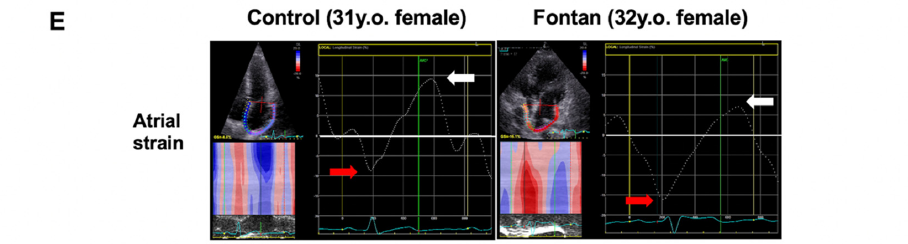
Figure 5. Atrial function in atrial septal defect and Fontan palliation. ( A ) TEE showing a right-to-left (R-L) shunt from a residual leak after ASD device closure with RA dysfunction. ( B ) Four-chamber views of end-systole (RAA max) and end-diastole (RAA min). The decreased RA fractional area change (FAC) suggests RA dysfunction. ( C ) Illustration of the Fontan circulation and the process of impairment of systemic ventricular relaxation after Fontan palliation. ( D ) Transmitral Doppler early diastolic (E-wave) and late diastolic (A-wave) velocities in a control subject, and the SV peak E-wave and A-wave inflow velocities in a patient with Fontan palliation (EC-TCPC). ( E ) Representative atrial strain curves in a patient with Fontan palliation (EC-TCPC) and a control subject. Peak negative (red arrow) and positive (white arrow) atrial strain are noted. TEE, transesophageal echocardiography; ASD, atrial septal defect; RA, right atrial; RAA, right atrial area; EC-TCPC, extracardiac total cavopulmonary connection.